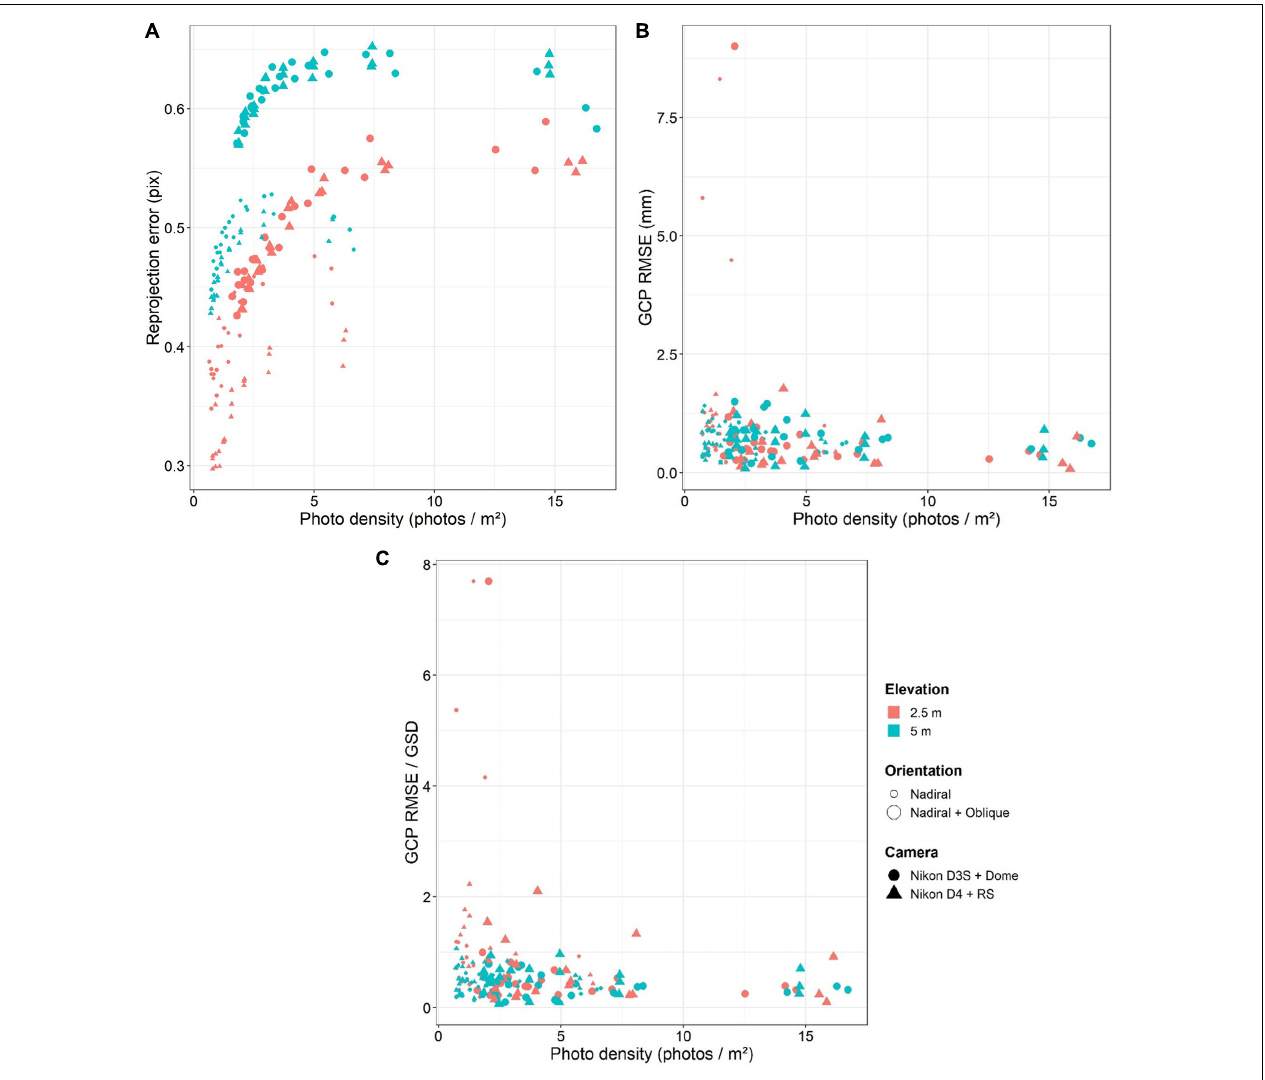
FIGURE 3 | Bundle adjustment metrics in function of the acquisition parameters. (A) Reprojection error; (B) GCP RMSE; and (C) GCP RMSE/GSD ratio; GCP RMSE, ground control point root mean square error; GSD, ground sample